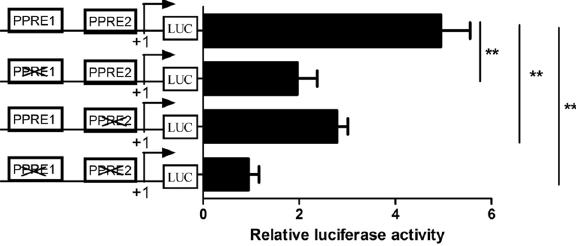
Figure 8. Site-directed mutagenesis of PPREs in the LPIN1 promoter reduces its transcriptional activity regulated by PPARG. **, P <